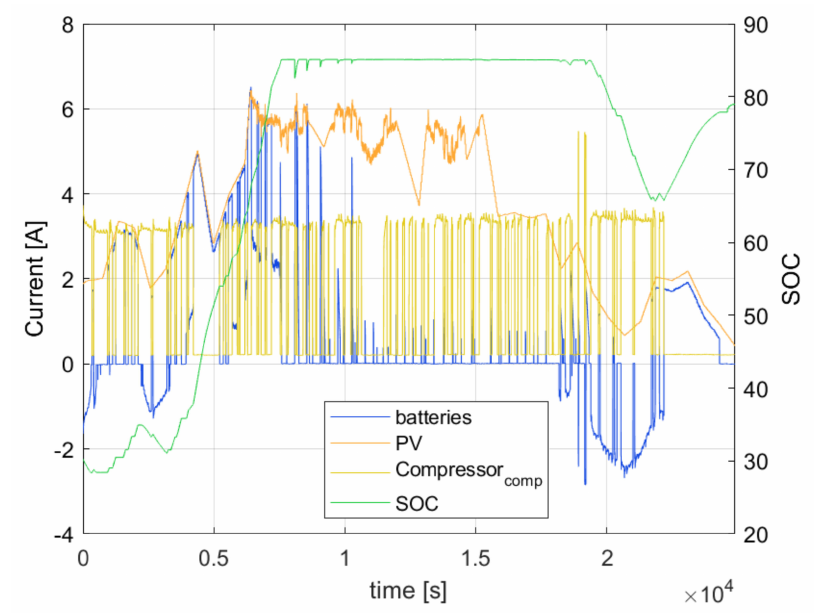
Figure 17. Experimental results for a reference day in